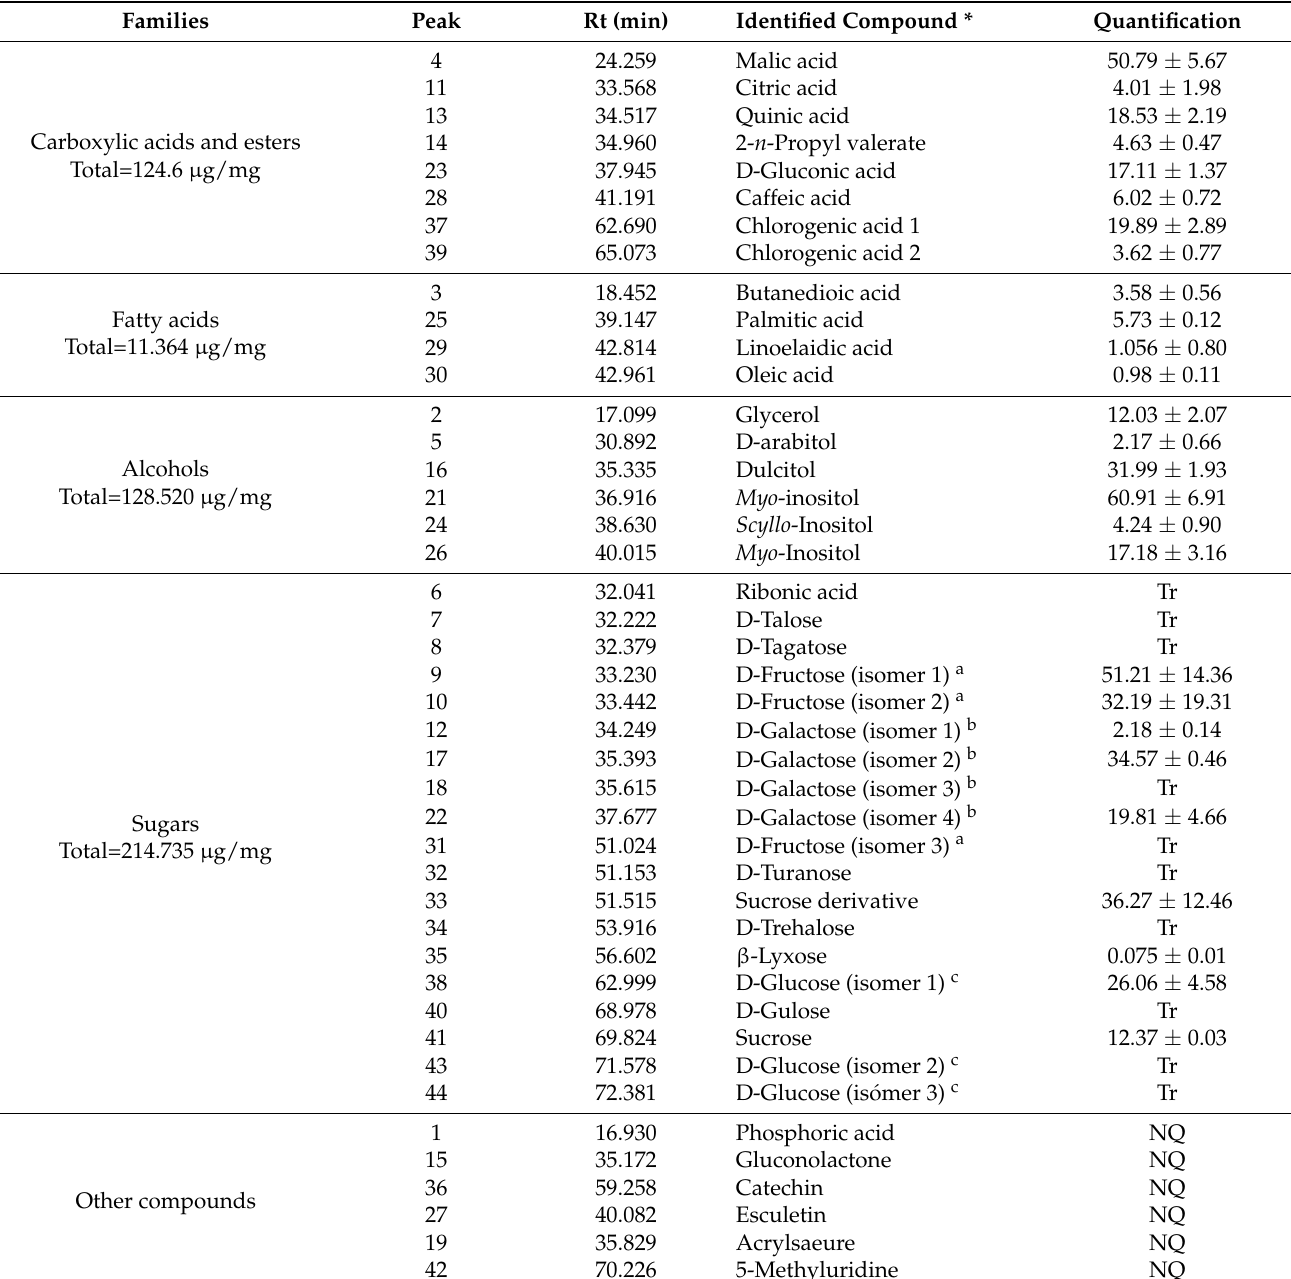
Table 2. Identified compounds on the hydromethanolic extract of W. saharae aerial parts by GC–MS ( µ g compound/mg extract). (SD: standard deviation, Rt: retention time, NQ: not quantified, Tr: traces). Families Peak Rt (min) Identified Compound * Quantification